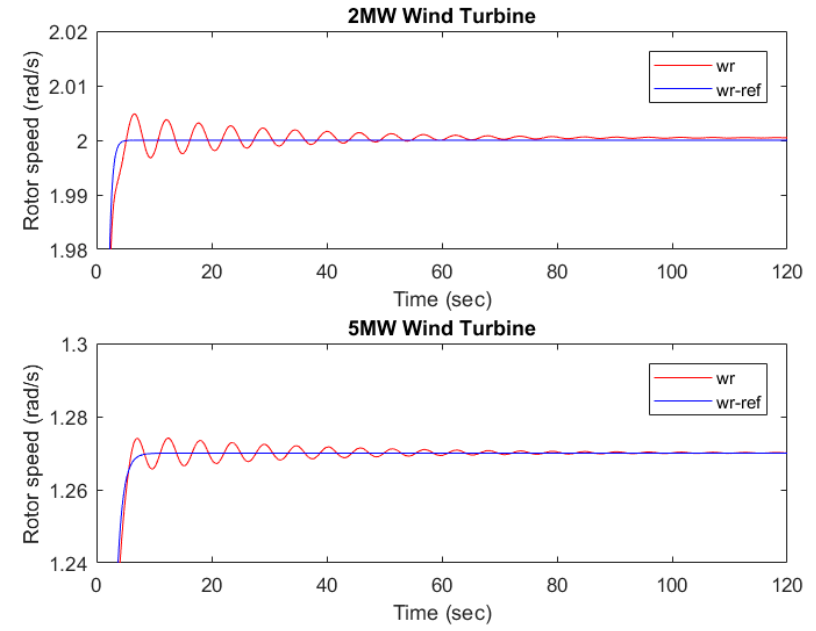
Figure 9. Steady - state rotor speed tracking of the 2 MW and the 5 MW wind turbines in the torque control region.